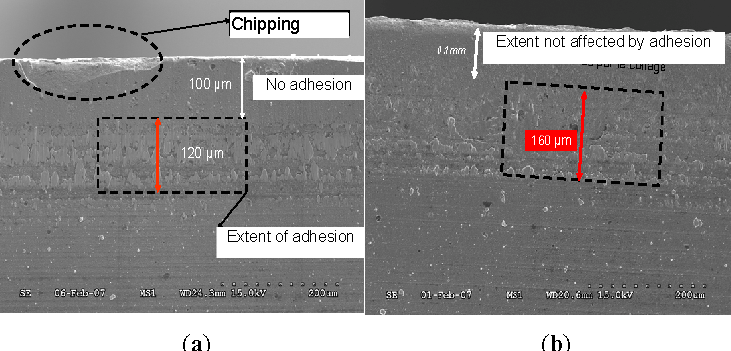
Figure 19. Adhesion extent on tool geometry B ( V ( b )